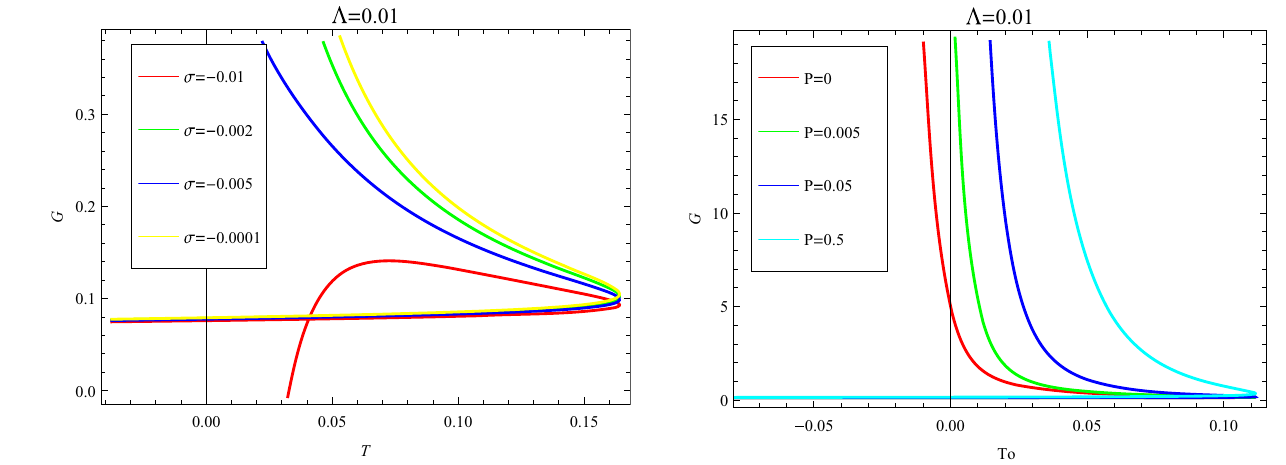
Fig. 11 Plot of G versus T o of the RBH with cosmological constant in